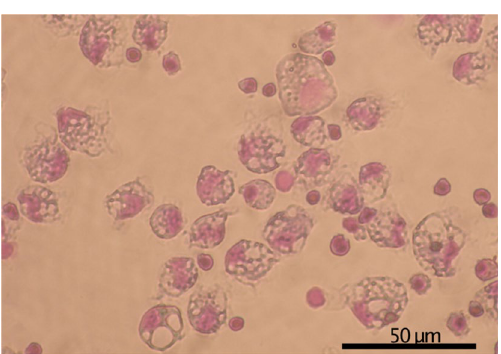
Figure 2. Microscopy image of the eye-sac cells from the bubble-eye goldfish. Eye-sac cells were harvested from eye sacs of untreated bubble-eye goldfish and stained with Giemsa. The scale bar represents 50